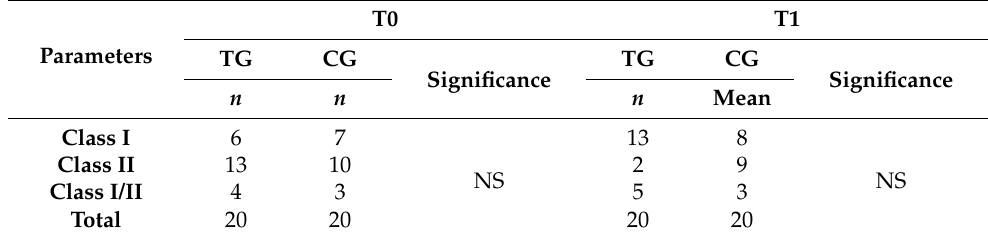
Table 3. Inferential statistics of data distribution of Angle malocclusion between the treatment group (TG) and control group. T0 = pre-treatment, T1 = post-treatment, SD = standard deviation, n = subjects’ number; significance set at p < 0.05 and based on chi-square test.